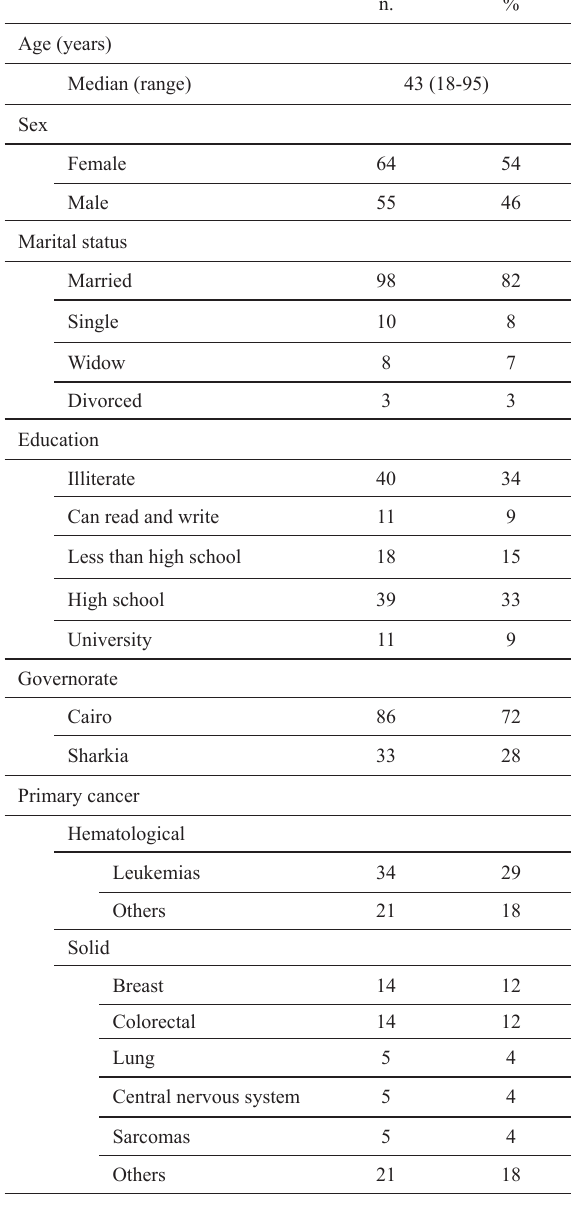
table 1: Patients’ characteristics.